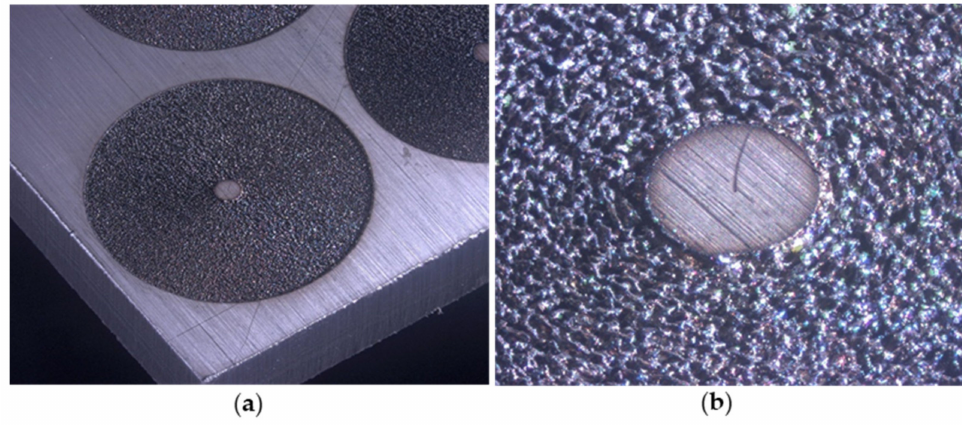
Figure 2. Shown is ( a ) the spiral after laser processing by the Coherent Monaco laser at 4.2 × 10 14 W/cm 2 , ( b ) a detailed view from the